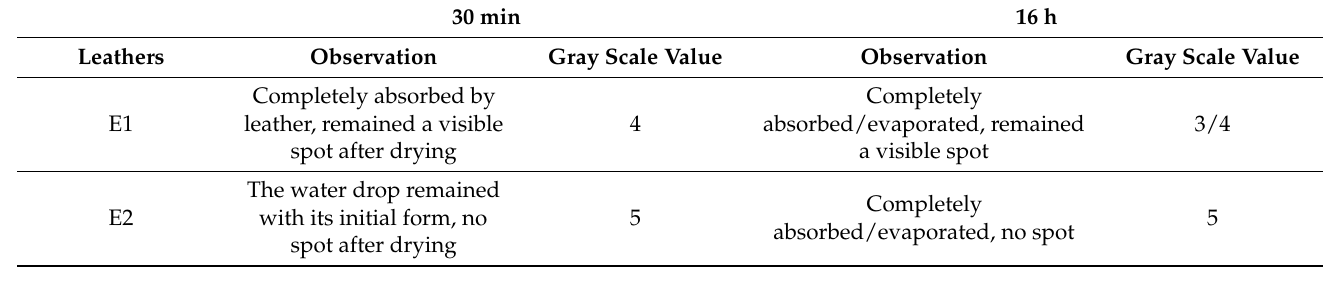
Table 6. Color fastness of leather samples to water spotting after 30 min and 16 h.